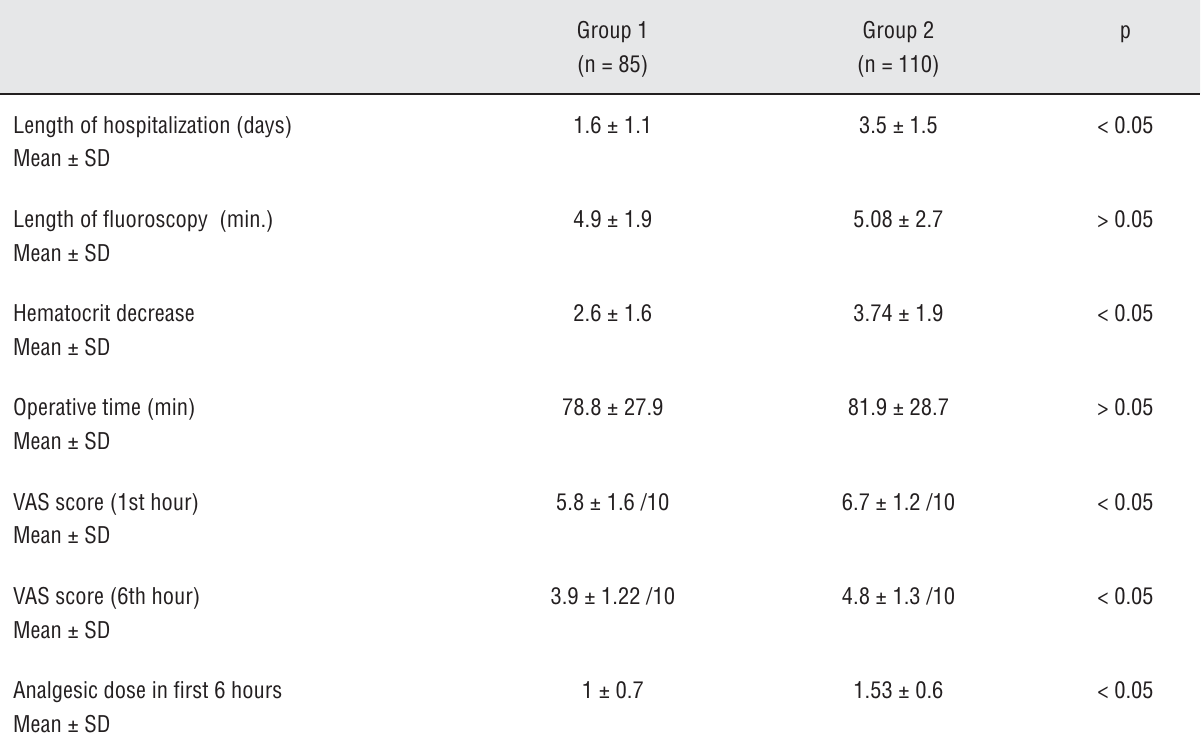
Table 2 - Operative parameters of both groups.